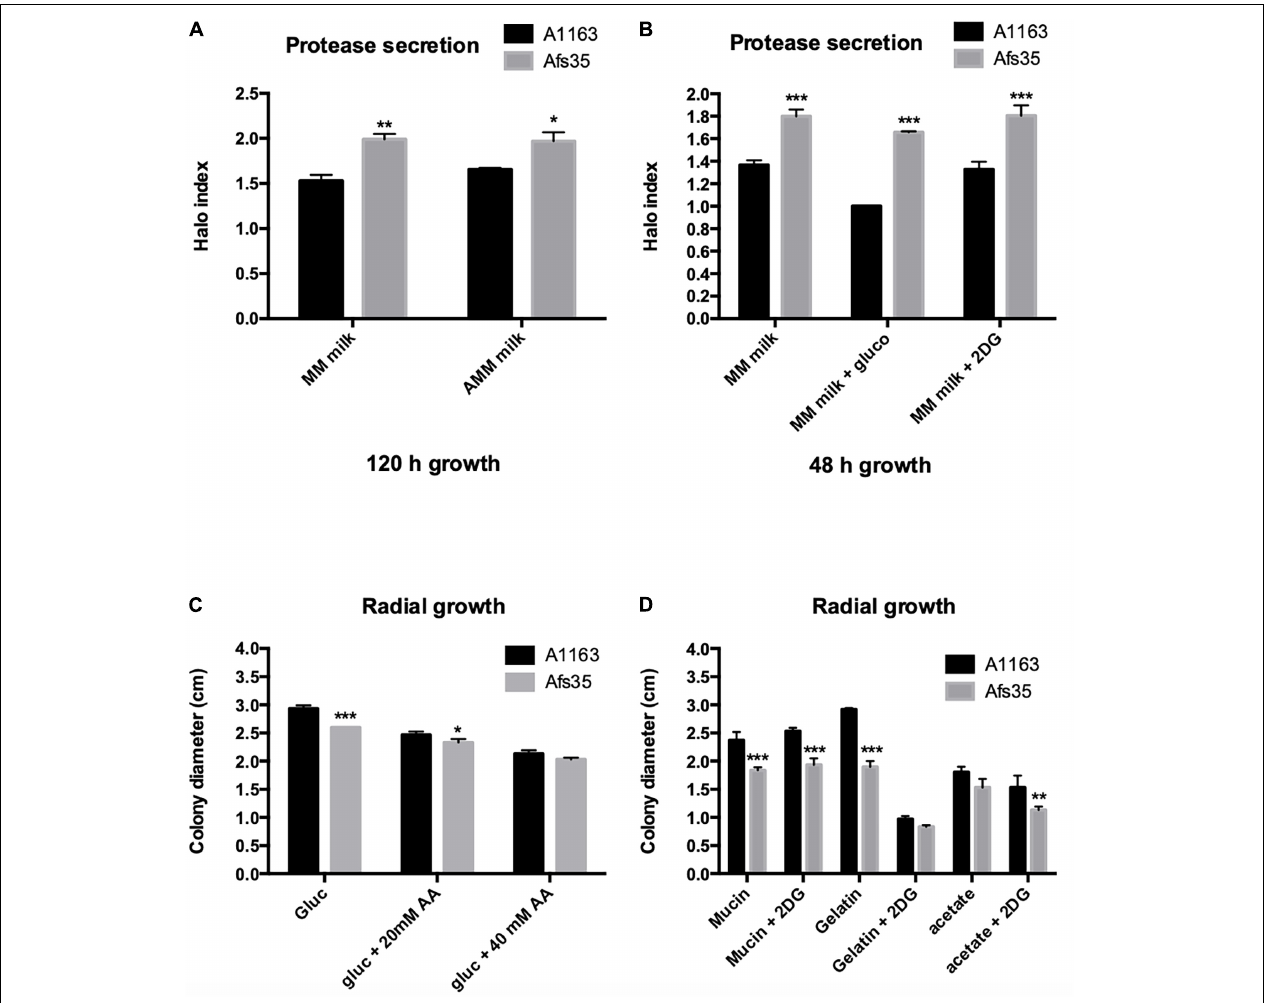
FIGURE 2 | Afs35 presents increased protease secretion when compared to strain A1163. (A,B) Protease secretion index (normalized by colony diameter) when strains were grown for 5 days on minimal medium (MM) or MM without any nitrogen source (AMM) supplemented with dry-skimmed milk and glucose or 2-deoxyglucose (2DG). (C,D) Colony diameter of strains Afs35 and A1163 when grown for 48 h on MM supplemented with glucose and increasing concentrations of allyl alcohol (AA) or in the presence of different carbon sources supplemented with 2-deoxyglucose (2DG). Error bars indicate standard deviations for three biological triplicates ( ∗ P -value < 0.05, ∗∗ P -value < 0.005, ∗∗∗ P -value < 0.0005 as determined by a two-way ANOVA